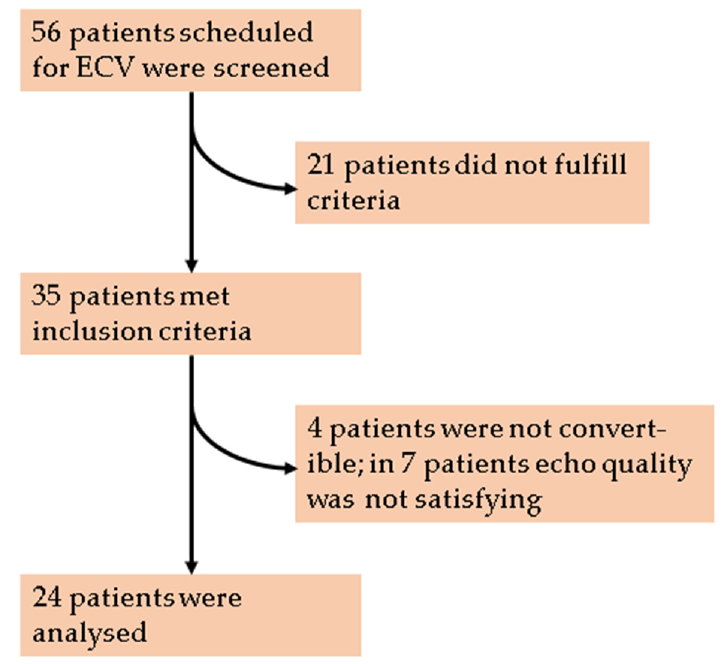
Figure 1. Patient flowchart. ECV: Electrical Cardioversion